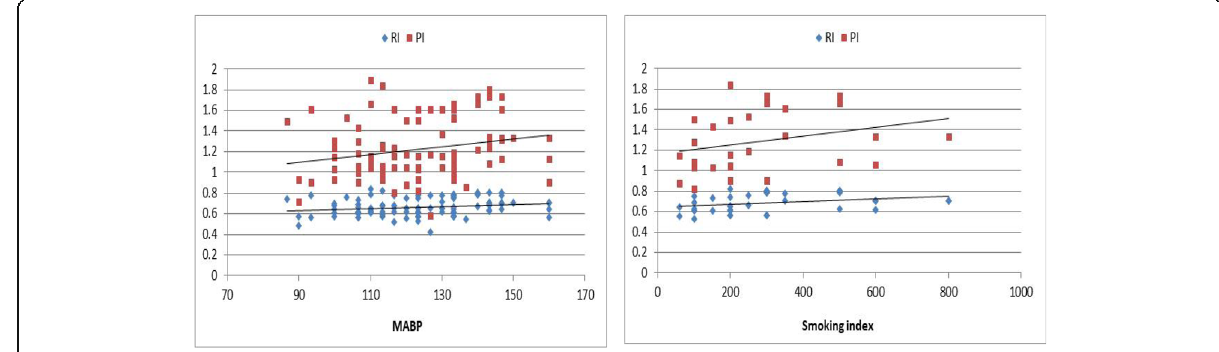
Fig. 2 RI and PI were positively correlated with hypertension (MABP) (left) and smoking (smoking index) (right)